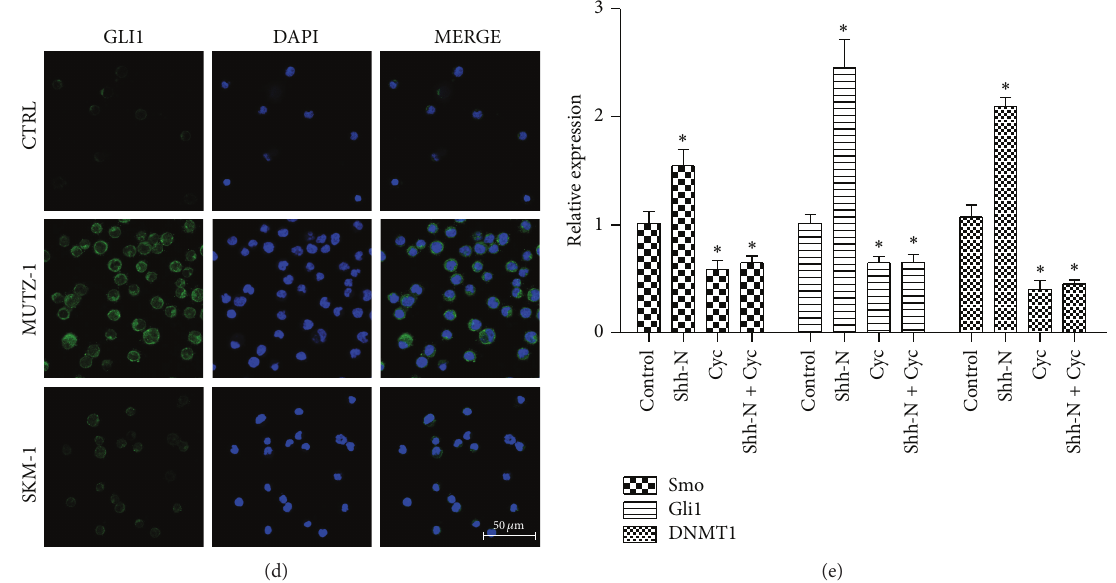
Figure 3: Modulation of Shh signaling influences the survival of MUTZ-1. MUTZ-1 cells were cultured in the presence of medium, exogenous Shh peptide (Shh-N) (500ng/mL), cyclopamine (Cyc) (20 𝜇 M), and Shh-N + cyclopamine for 48 h, and cell survival was determined by the CCK8 and Annexin V-PI assays. There was significantly increased proliferation of MUTZ-1 cells in the presence of exogenous Shh peptide and decreased cell proliferation in the presence of cyclopamine, as determined by the CCK8 assay (a). Cyclopamine at concentrations of 10, 20, and 40 𝜇 M induced inhibition of cell proliferation ((b), × 200) and increased apoptosis (c) in MUTZ-1 cells within 48 h in a dose-dependent manner.ExpressionofGLI1proteininCD34 + stemcellsfromhealthydonors,MUTZ-1cells,andSKM-1cellsshownbyconfocallaserscanning microscopy (d). Real-time PCR analysis of Smo, Gli1, and DNMT1 after treatment with Shh-N (500 ng/mL) and/or cyclopamine (20 𝜇 M) for 72 h (e). Expression of beta-actin (ACTB) was used as a housekeeping control gene. Fold-change was calculated with 2 −ΔΔ Ct method compared with controls. Results are expressed as average ± SEM of triplicates each. ∗ 𝑃 < 0.05